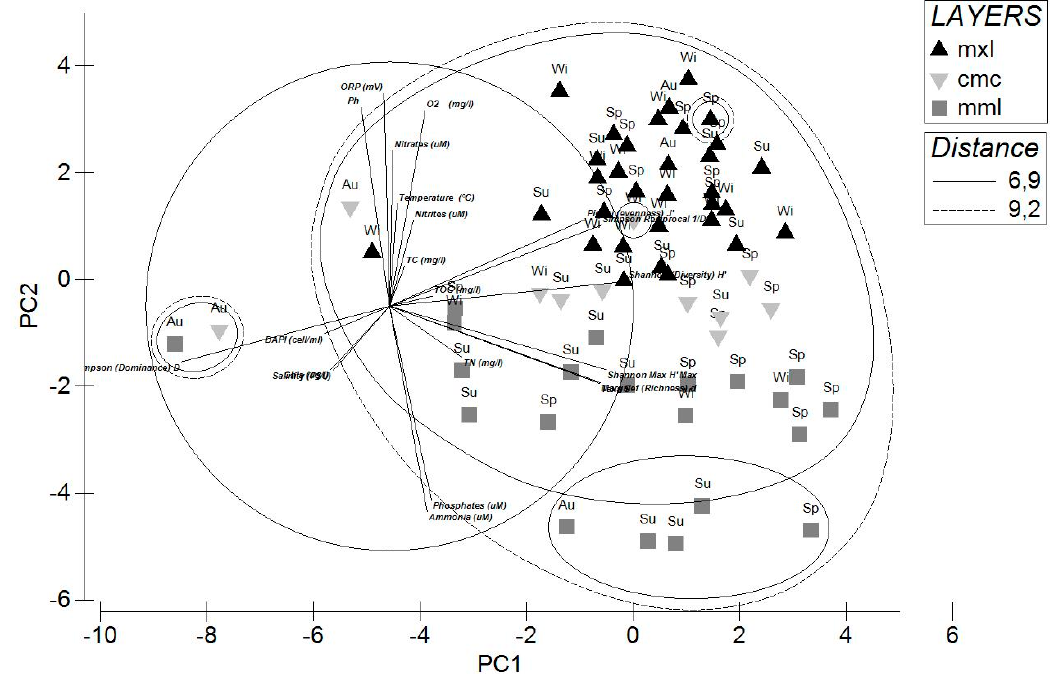
Figure 3. Principal component analysis computed on ARISA data, diversity indices, chemical-physical parameters, DAPI counts and nutrient concentration (mxl: mixolimnion; cmc: chemocline; mml: monimolimnion).